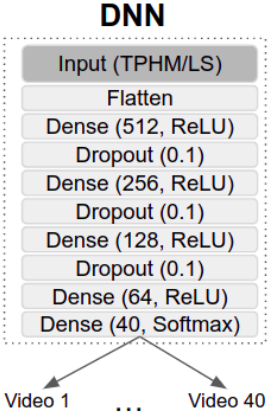
Figure 3. A fully connected Dense Neural Network (DNN) architecture for predicting Video ID in music video classification problems. ConvAE’s LS and TPHM are input to DNN at separate instances to examine optimal